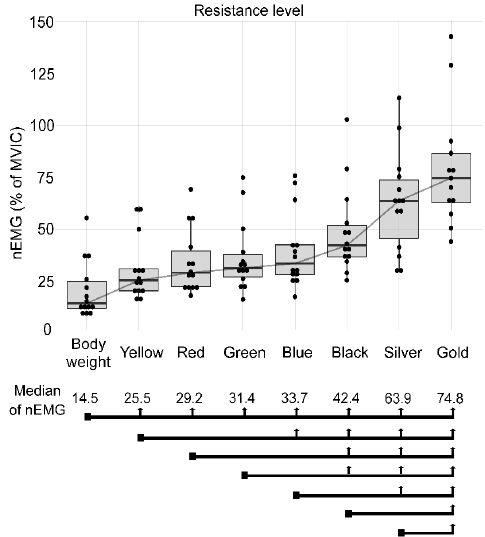
Figure 5. Median muscle activation (median of nEMG) for the different conditions: body weight, yellow, red, green, blue, black, silver and gold elastic band. The square point at the beginning of the black line marks the compared condition and the vertical arrows show significant differences between conditions. Figure 6 shows the relationship between the averaged nEMG of the knee extensors and RPE (a), as well as between the intensity of the different conditions and the nEMG (b) and RPE (c). Regarding the first, the averaged nEMG presented a medium correlation ( ρ = 0.61) with the RPE. Regarding the association between intensity and nEMG, the correlation was also medium ( ρ = 0.69). Finally, the correlation between intensity and RPE was medium–high ( ρ = 0.71).